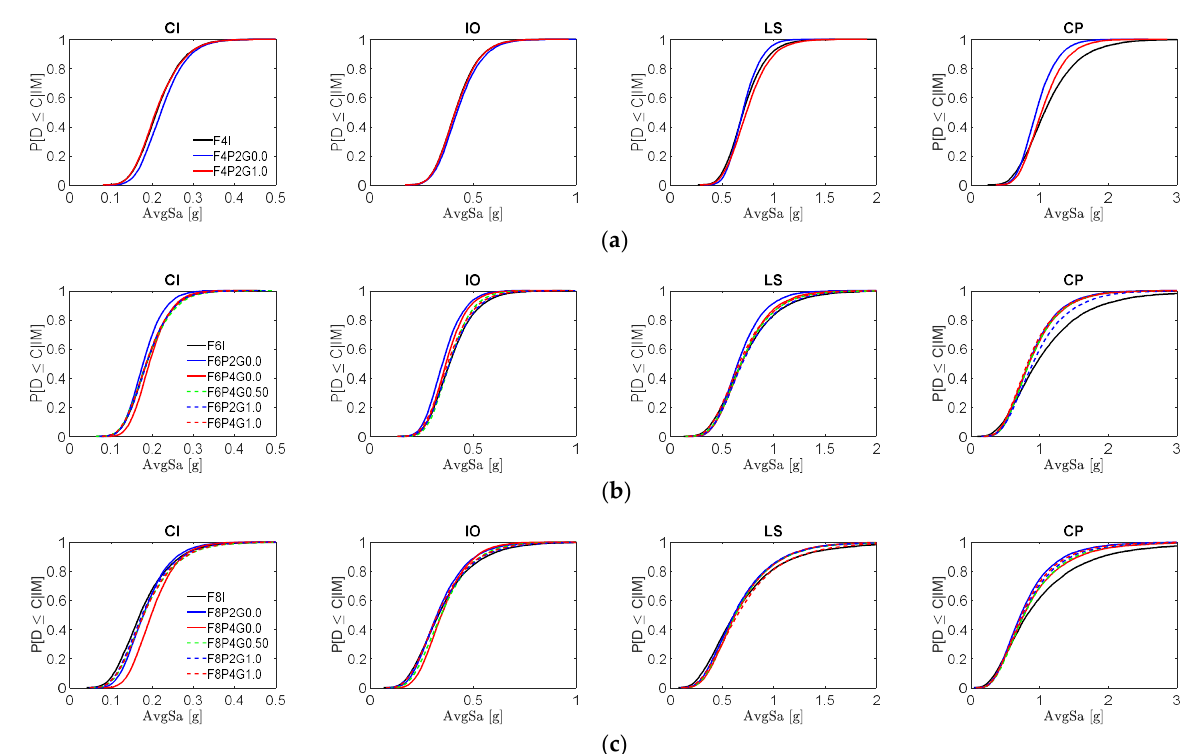
Figure 21. Fragility functions for different structures involving floor-to-floor pounding and different values of the seismic separation distance ratio when the left-hand side structure is a 4-storey ( a ), 6-storey ( b ) and an 8-storey ( c ) building.